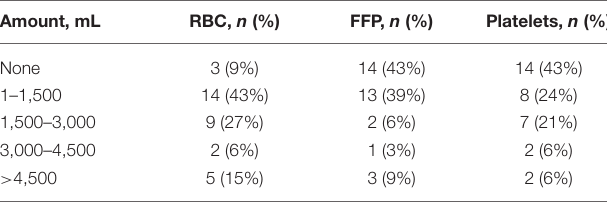
TABLE 2 | An overview of the use of blood products during support with extracorporeal membrane oxygenation (ECMO) for all patients ( n =